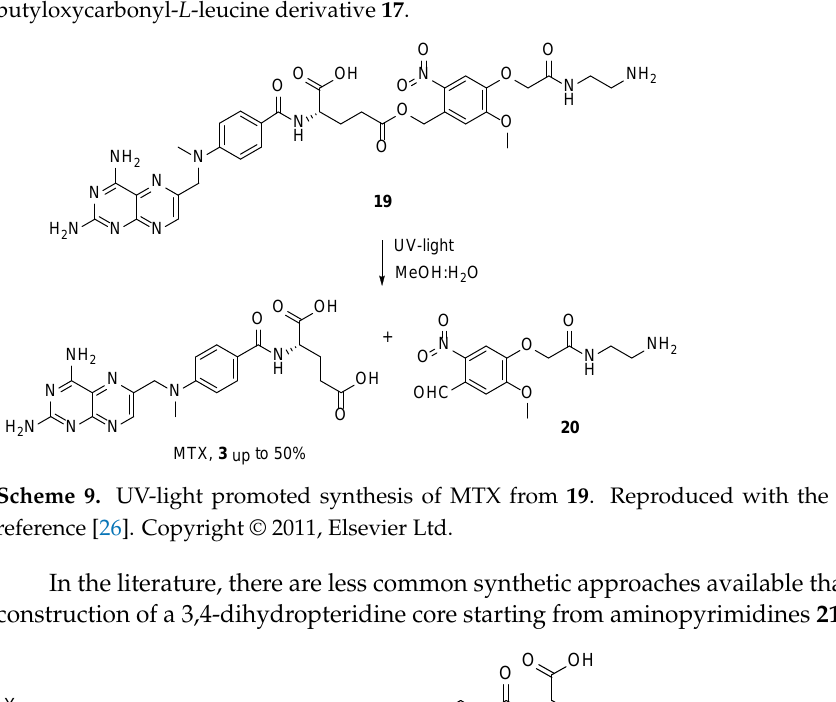
Scheme 8. Three-step synthesis of MTX starting from di- tert -butyl ester of MTX 16 and N - tert -bu- tyloxycarbonyl- L -leucine derivative 17